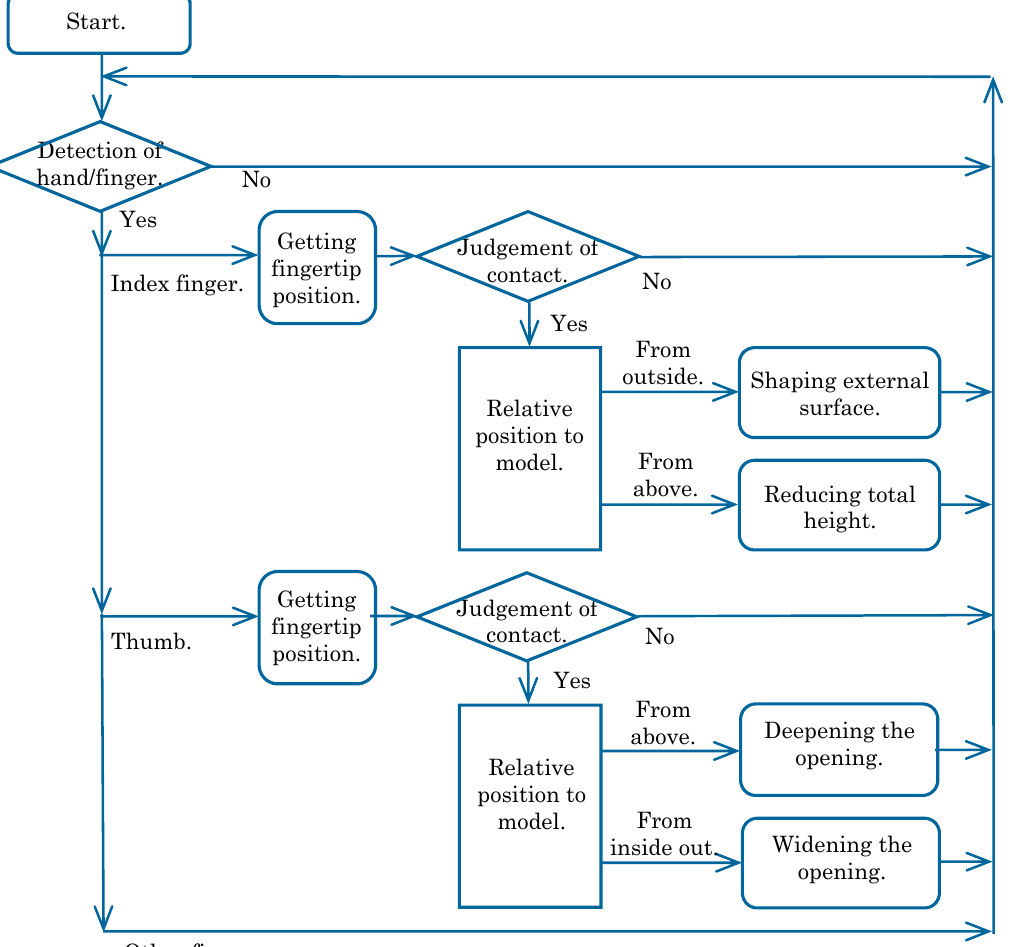
Figure 6. Operation procedure of simulated experience system.